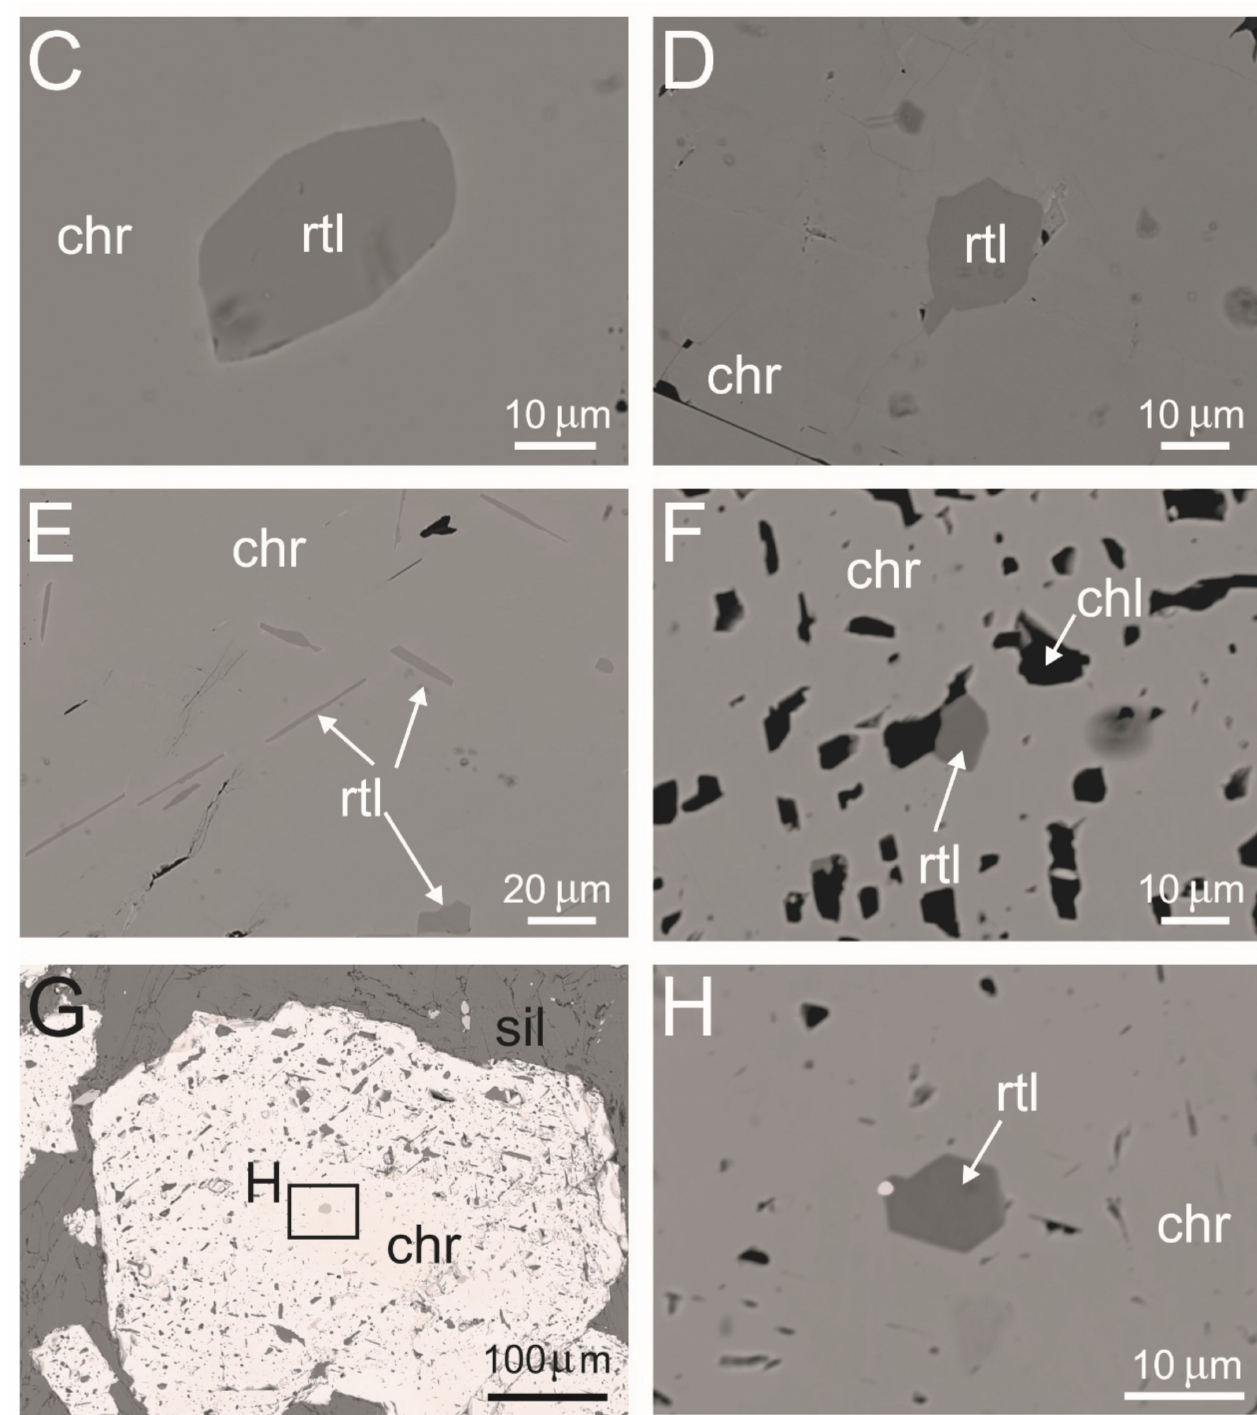
Figure 8. BSE images of rutile inclusions in chromite from various localities. Polygonal rutile included in chromite of Merensky Reef ( A ). Anhedral rutile included in altered chromite of Nuasahi (sample NS9) ( B – D ). Tiny acicular needles of rutile developed according to cubic symmetry of recrystallized chromite of Nuasahi (sample NS9) ( E ). Small rutile crystals included in chromite riddled with holes (Cedrolina, sample CD105C) ( F ). Euhedral rutile with a tiny droplet of uraninite (white spot) in the core of altered chromite grain (Cedrolina, sample CD47C) ( G , H ). Abbreviations as in Figures 1 and 4. At all localities, except Cedrolina, sub-euhedral rutile occurs as composite aggregates with PGM, Ni-Cu sulfides, and silicate, completely embedded in